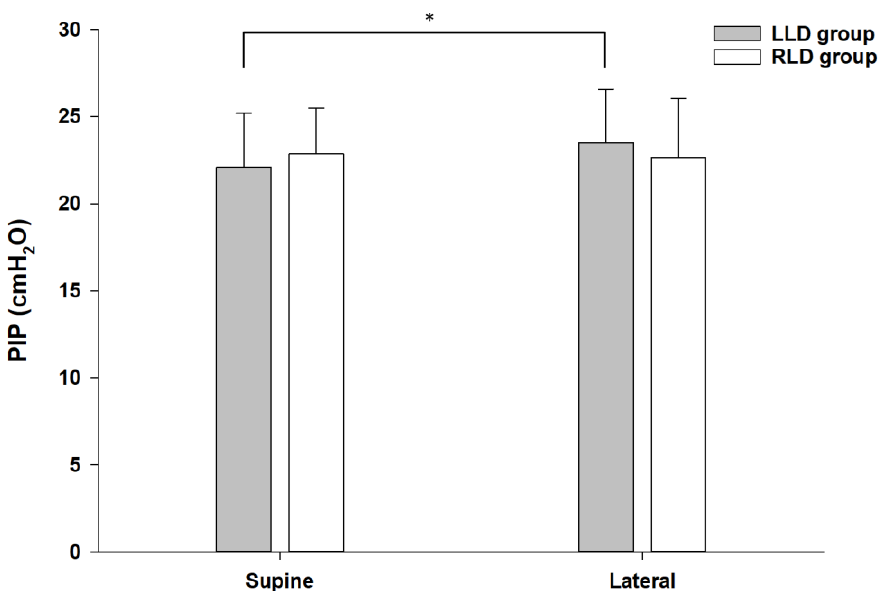
Figure 2. The changes of PIP at supine position and after later positioning. The grey boxes show the mean PIP with standard deviation of the patients in the LLD group. The white boxes show the mean PIP with standard deviation of the patients in the RLD group. * p = 0.001 compared to supine position. PIP, peak inspiratory pressure; LLD, left lateral decubitus; RLD, right lateral decubi- tus.